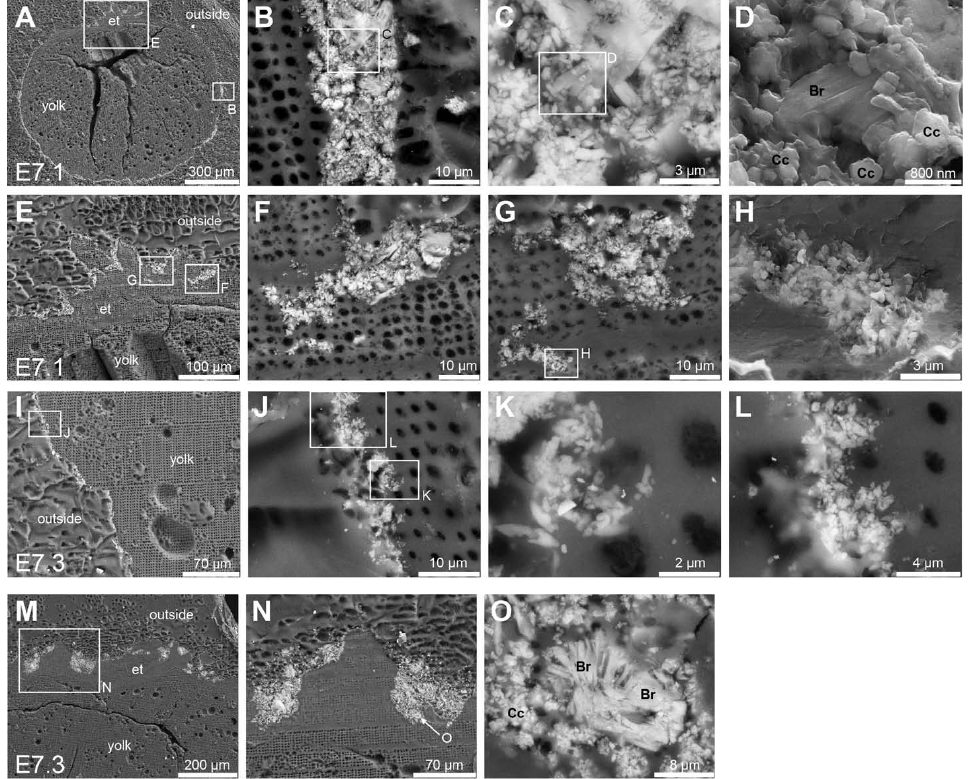
Fig. 6. (A) – (O) Backscattered electron (BSE) images and close-up views ( D and H as secondary electron images) of sliced post-experimental eggs from experiments E7.1 and E7.3 illustrating crystal texture, size and distribution of the mineralization around and within the mineralized embryos (for further details see text; Br=brushite; Cc=calcite; et=embryonic tissue of the germ